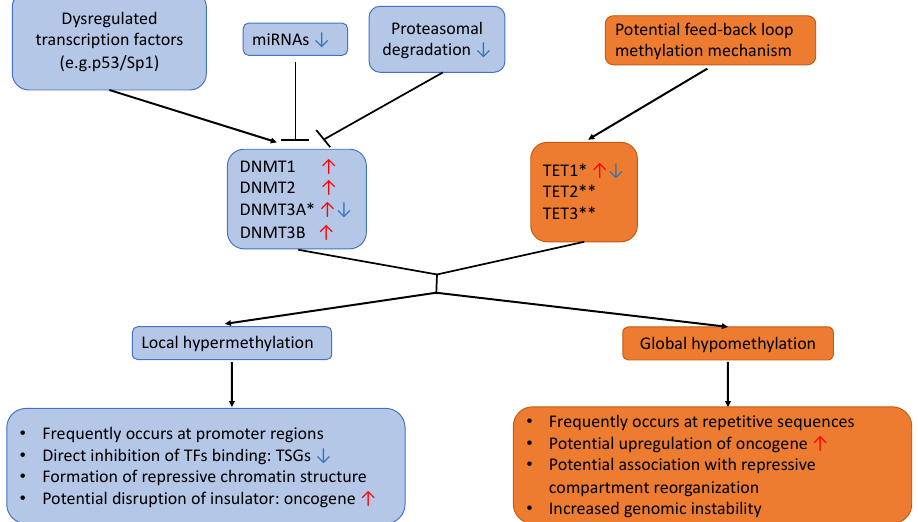
Figure 3. Possible mechanisms and consequences of DNA methylation alterations in lung cancer.